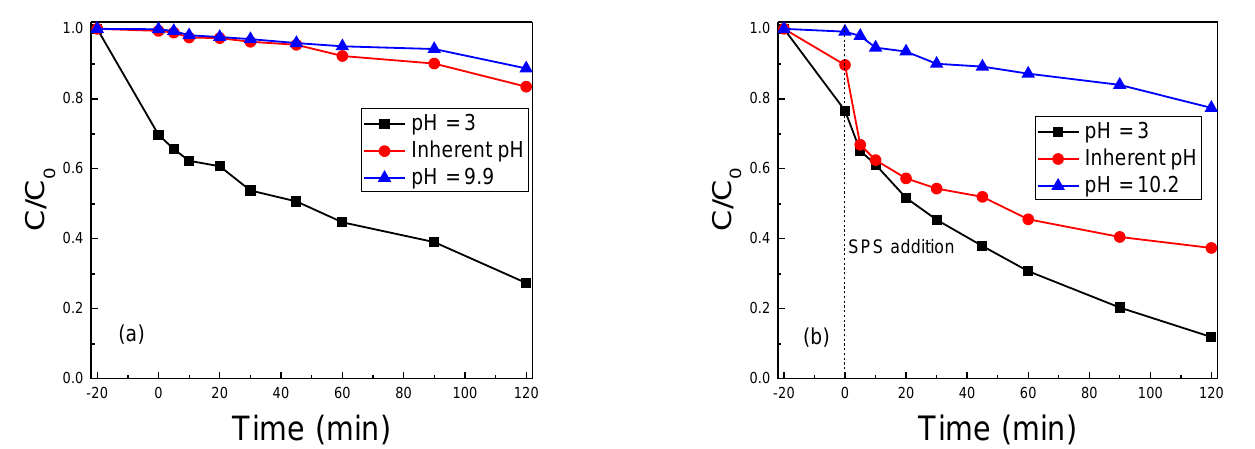
Figure 6. Effect of initial solution pH on the adsorption ( a ) and degradation ( b ) of 500 µ g L − 1 SMX adsorption with 500 mg L − 1 RHB700 in UPW.